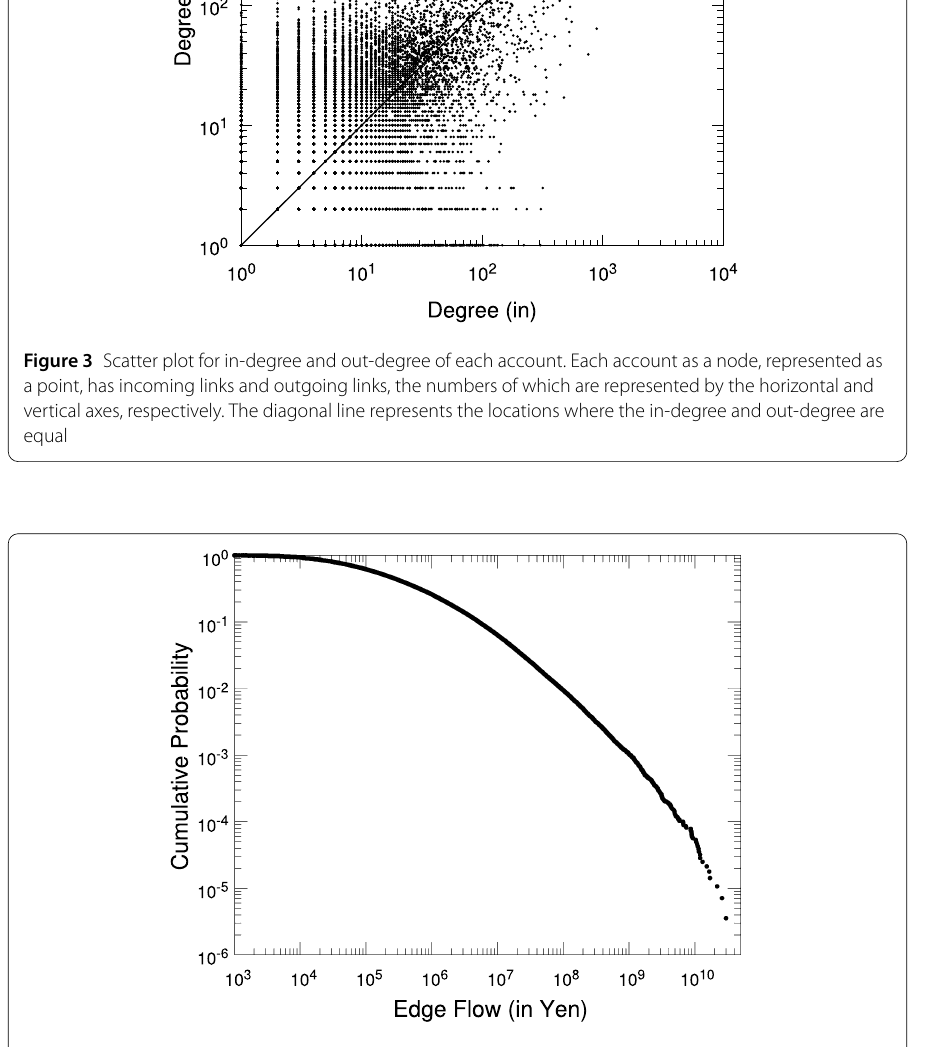
Figure 4 Distribution for the flows of links. Complementary cumulative distributions for the amount of money defined by f ij between each pair of accounts i and j (see Fig.